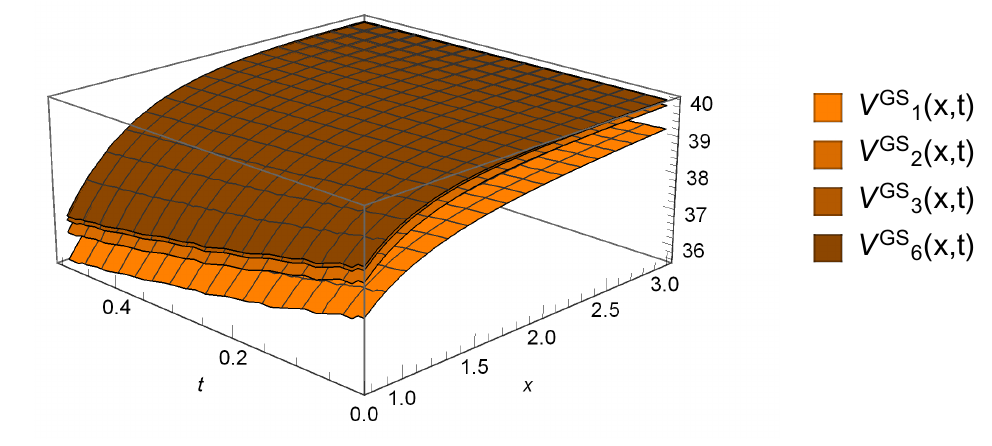
Figure 7. Sequence of solutions for n =